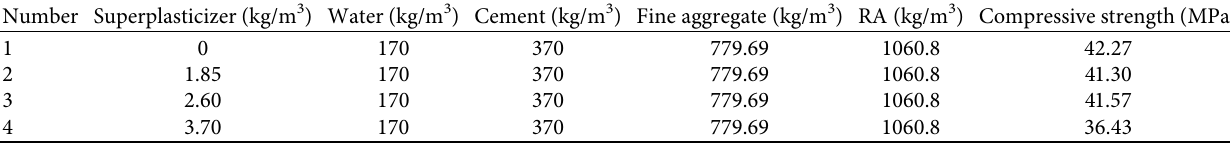
Table 4: Superplasticizer amount mixture.